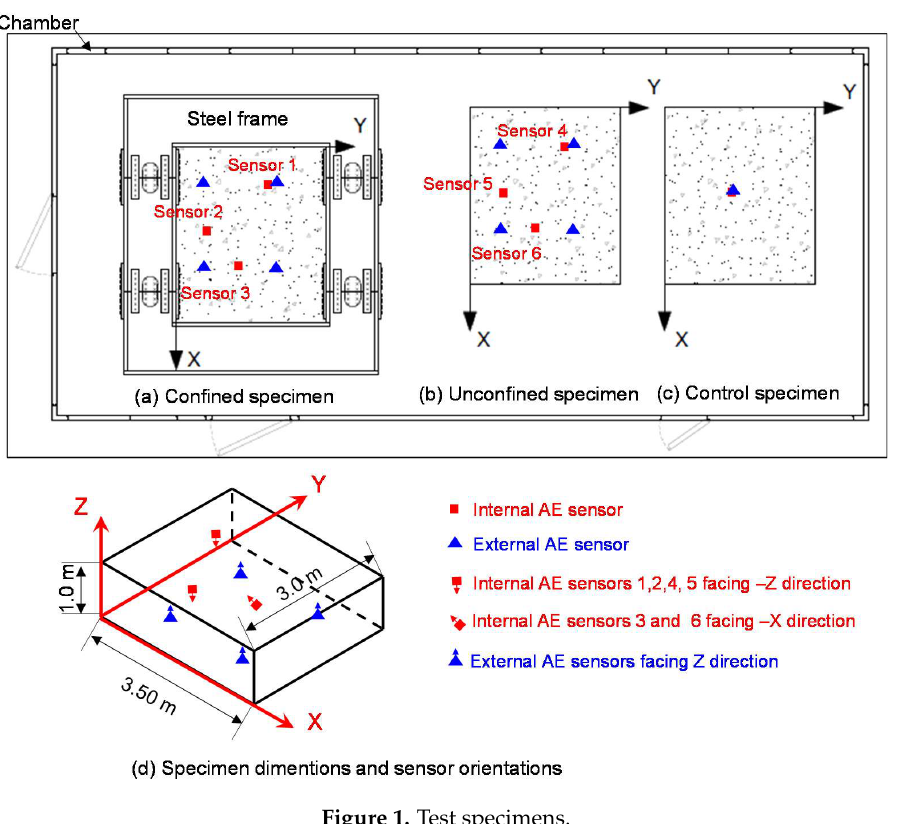
Figure 1. Test specimens.